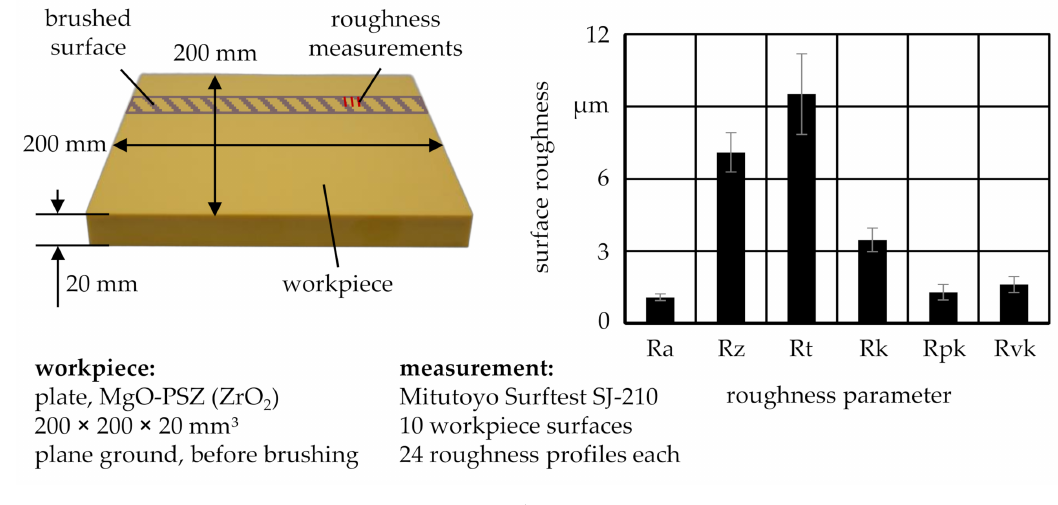
Figure 2. Workpiece